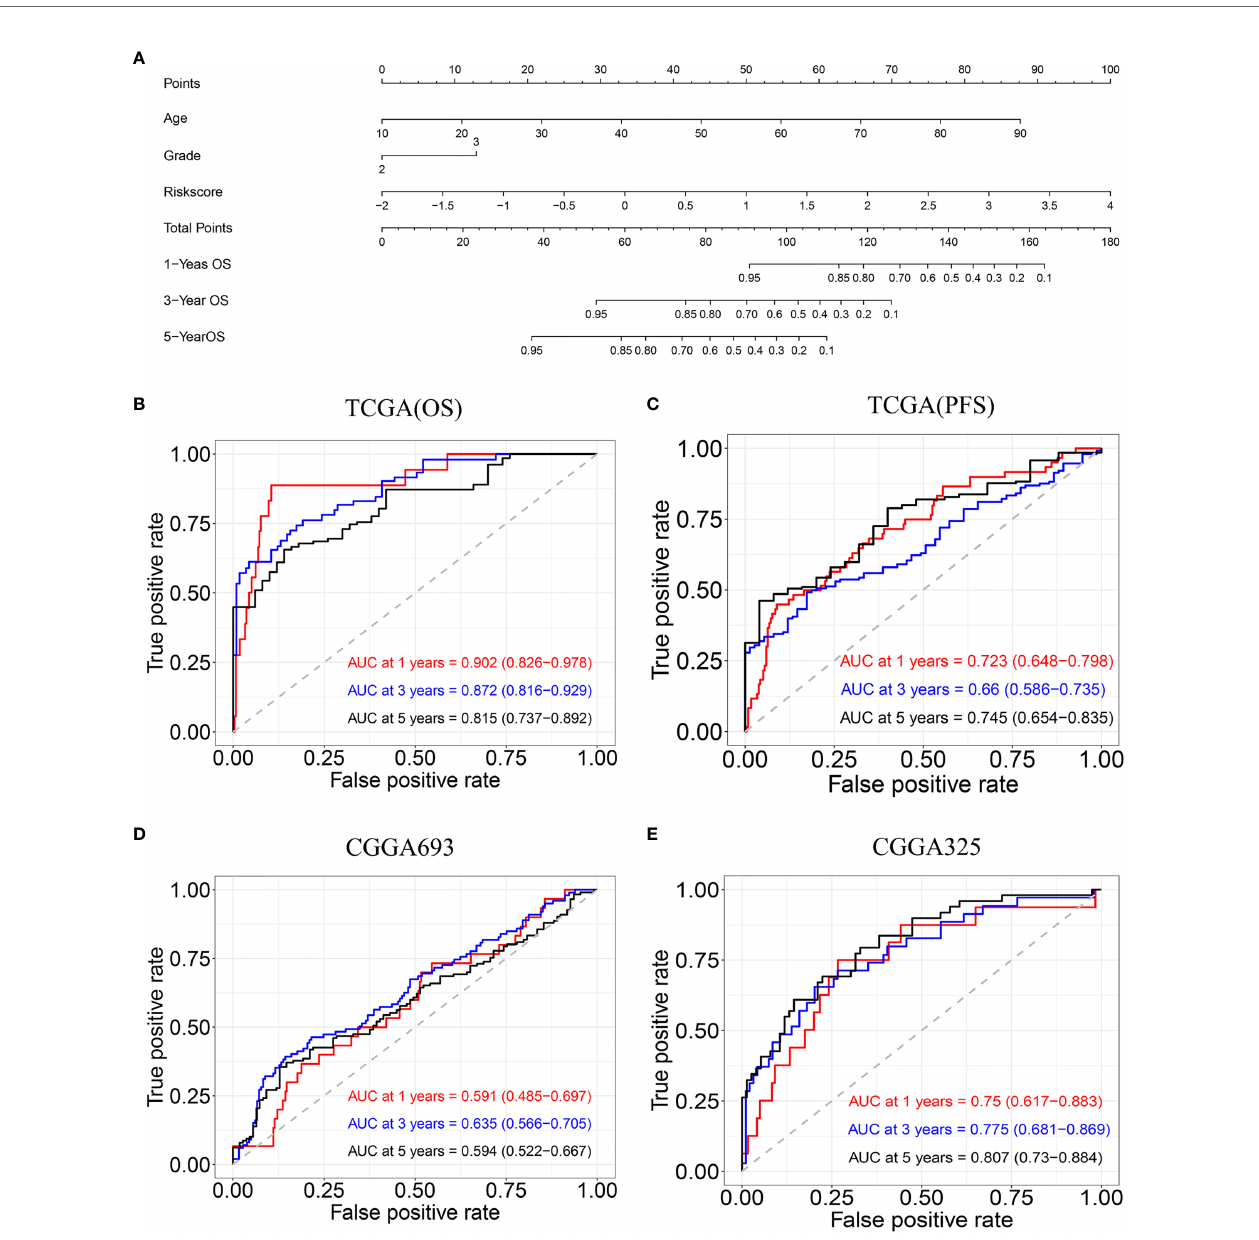
FIGURE 6 | Construction and validation of nomogram model. (A) Nomogram model for predicting the probability of 1-, 3-, and 5-year OS in LGG. (B) Time-dependent ROC curve analyses of the nomogram model in the TCGA(OS). (C) Time-dependent ROC curve analyses of the nomogram model in the TCGA(PFS). (D) Time-dependent ROC curve analyses of the nomogram model in the CGGA693. (E) Time-dependent ROC curve analyses of the nomogram model in the